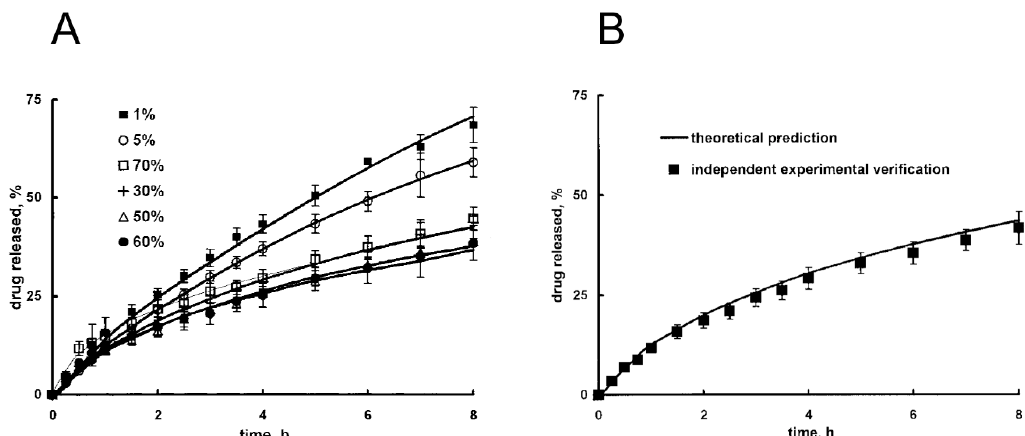
Figure 5. Release of theophylline as a function of time from hydroxypropyl methylcellulose (HPMC) matrices in phosphate buffer (pH 7.4) for different value of initial drug loading (expressed as w/w %) ( A ). Model validation through theoretical prediction of independent experimental data (theophylline release, initial drug loading 40%) ( B ). Adapted from Siepmann and Peppas [129], Copyright 2000 Springer Nature.